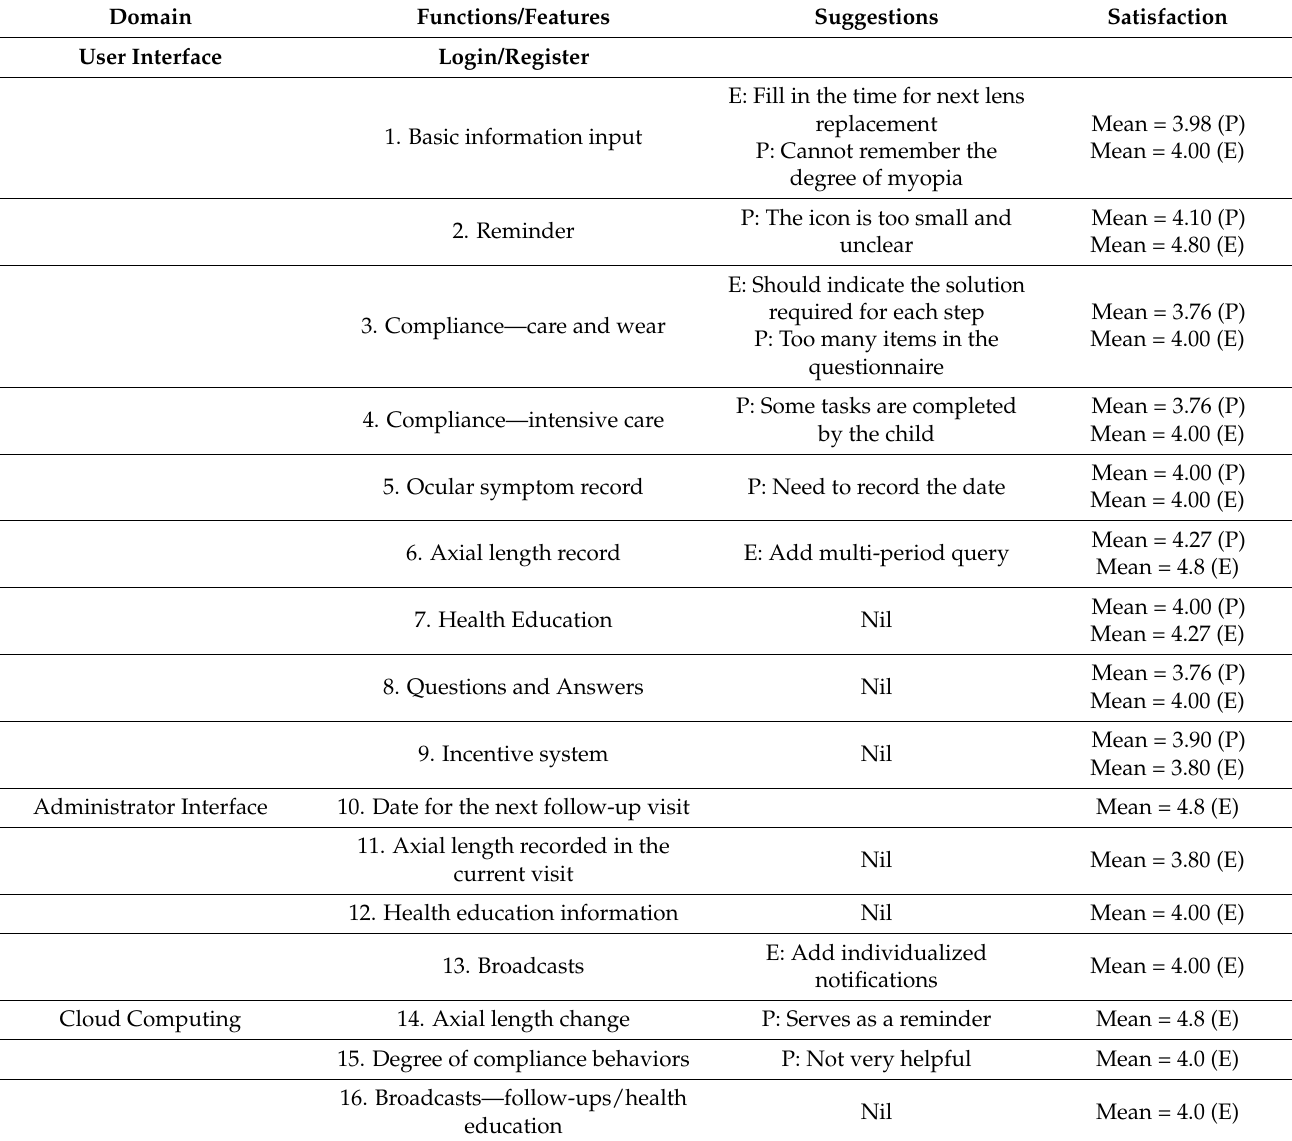
Table 6. Feedback of features and functions of the EYE is OK